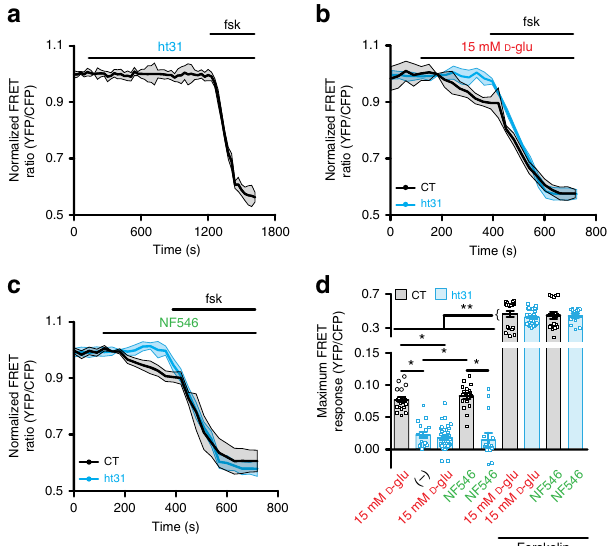
Fig. 1 ht31 prevents glucose/NF546-induced cAMP in human cells. a Average ICUE3-PM FRET trace (mean = solid line; SEM = shade) in response to application of 10 μ M ht31 and after 1 μ M forskolin in human arterial myocytes. Time courses of the average ICUE3-PM FRET traces (mean = solid line; SEM = shade) in human arterial myocytes in response to b 15 mM D-glucose (D-glu) and c 500 nM NF546 and after 1 μ M forskolin in control (CT) and ht31-treated cells. d Plot of maximum FRET responses for human male/female arterial myocytes exposed to the ht31 peptide alone ( n = 17 cells/2 humans), 15 mM D-glu ( n = 19 cells/3 humans for − ht31 and n = 36 cells/3 humans for + ht31) and NF546 ( n = 18 cells/3 humans for − ht31 and n = 14 cells/3 humans for + ht31) in the absence and presence of forskolin. * P < 0.05 with Kruskal – Wallis one-way ANOVA with Dunn ’ s multiple comparisons. The single asterisks highlight signi fi cant differences between all datasets in the absence of forskolin. The double asterisks indicate a statistical difference within the same experimental group in the absence and presence forskolin. P = 0.0002 for 15 mM D-glu-ht31 and ht31-ht31 + 15 mM D-glu + forskolin. P = 0.0002 for NF546-NF546 + forskolin. All other signi fi cant P values are <0.0001. Data represent mean ± SEM. Source data are provided as Source data fi le.